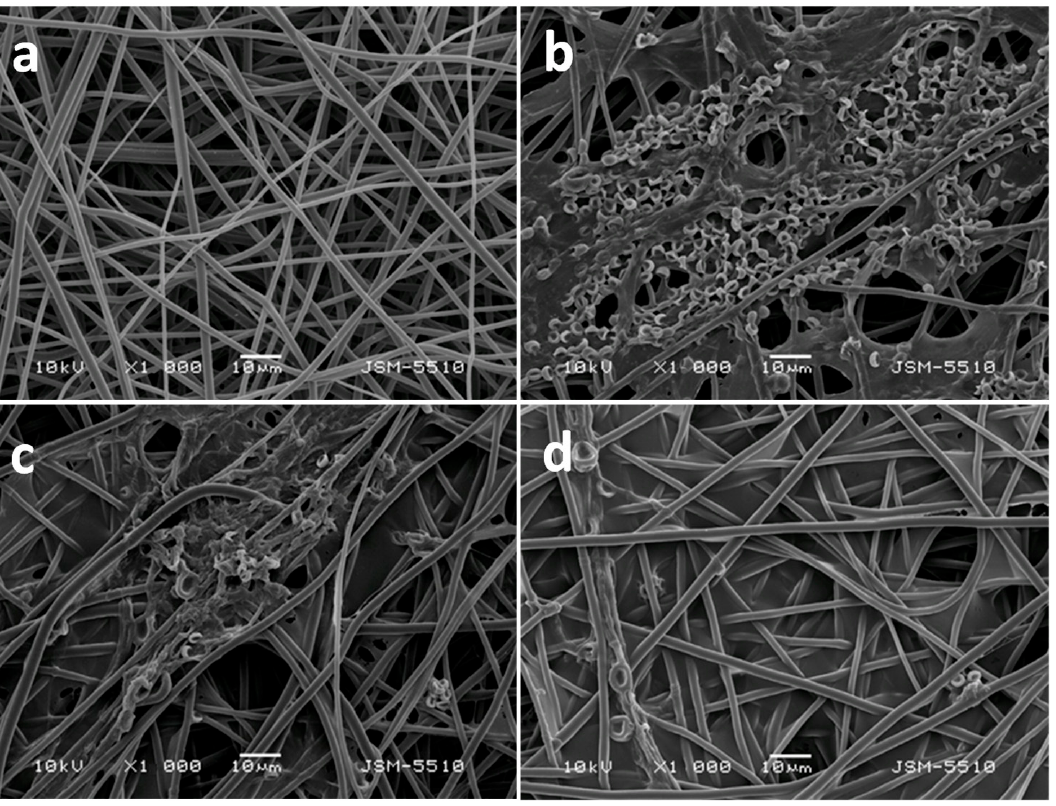
Figure 7. Representative SEM images of ( a ) PLLA mat, ( b ) PLLA mat coated with oligochitosan/ T. asperellum spores, ( c ) PLLA mat coated with LMW chitosan/ T. asperellum spores, and ( d ) PLLA mat coated with HMW chitosan/ T. asperellum spores; magnification ×1000 [115].